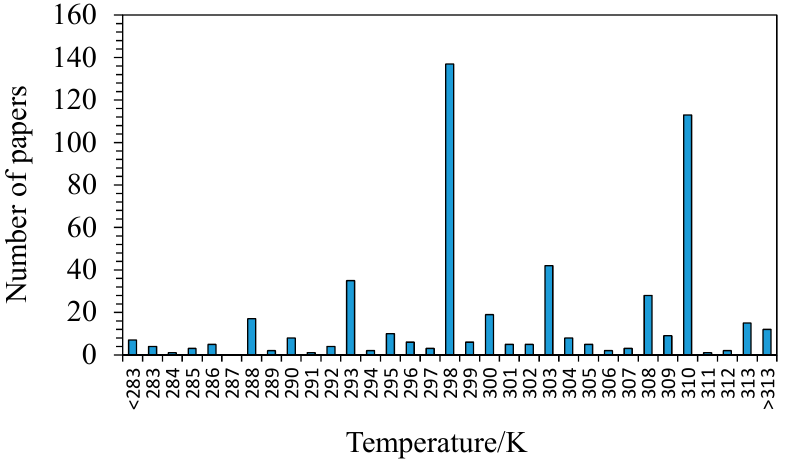
Figure 6. Temperatures used to study albumin–ligand binding in the papers from the dataset.